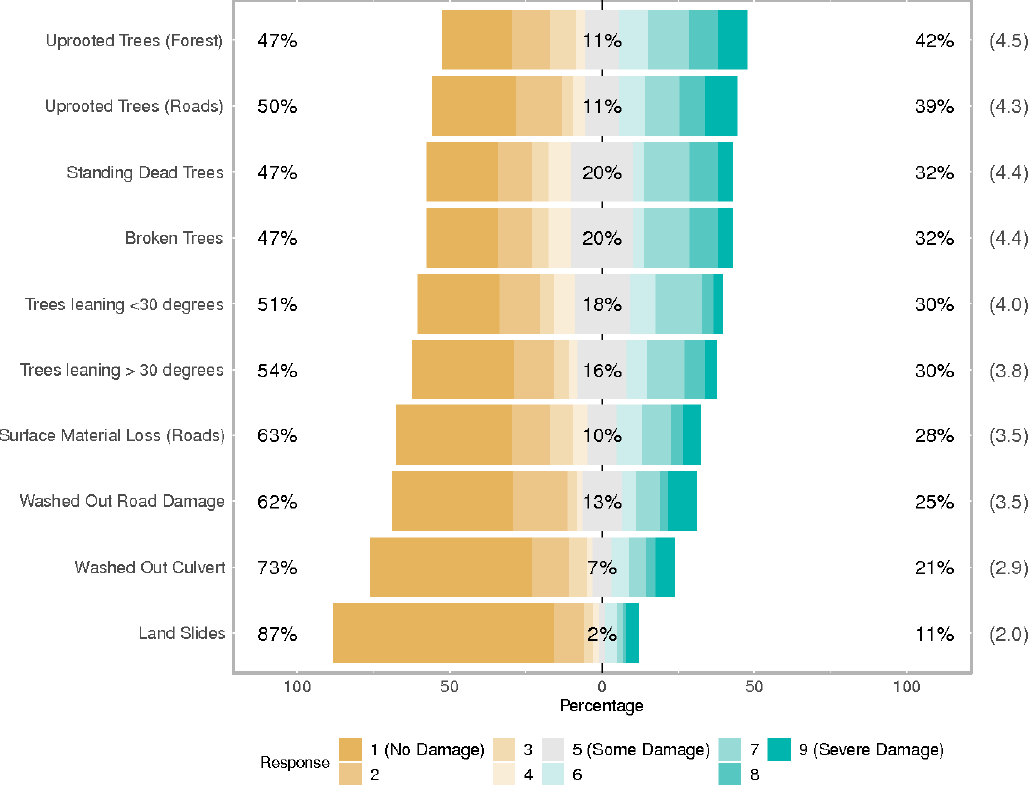
Figure 6. Percent of South Carolina Tree Farmers in 45 counties indicating damage (9-point Likert scale where 1 = no damage, 5 = some damage and 9 = severe damage) on the property that sustained the most damage from hurricane Matthew in 2016 (June–August 2017 data collection). Values in parentheses represent mean response values. Percent values to the left show the fraction of respondents that reported low damage (values 1 to 4) for the particular damage item, the percent values in the center show the fraction of respondents that reported some damage (value 5), and the percent values to the right show the fraction of respondents reporting high damage (values 6 to 9).